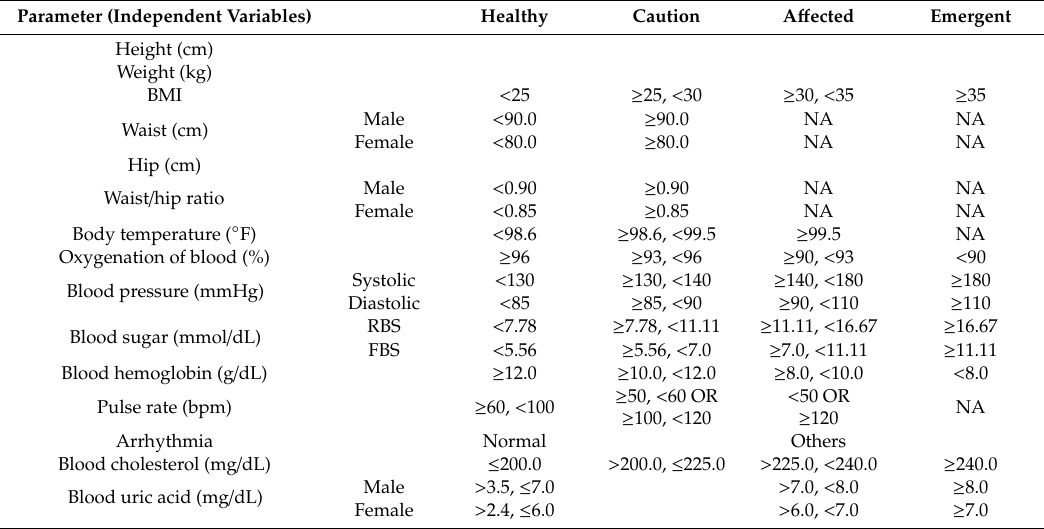
Table 2. PHC data range validation chart.